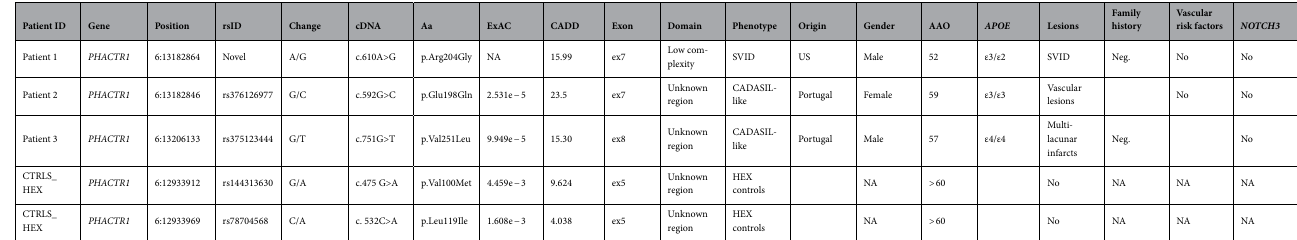
Table 3. PHACTR1 coding variants detected in the SVID-CADASIL-like cohort and in the HEX database cohort of controls. CTRLS controls, Aa amino-acid, AAO age at onset, SVID small vessel ischemic disease, Neg.